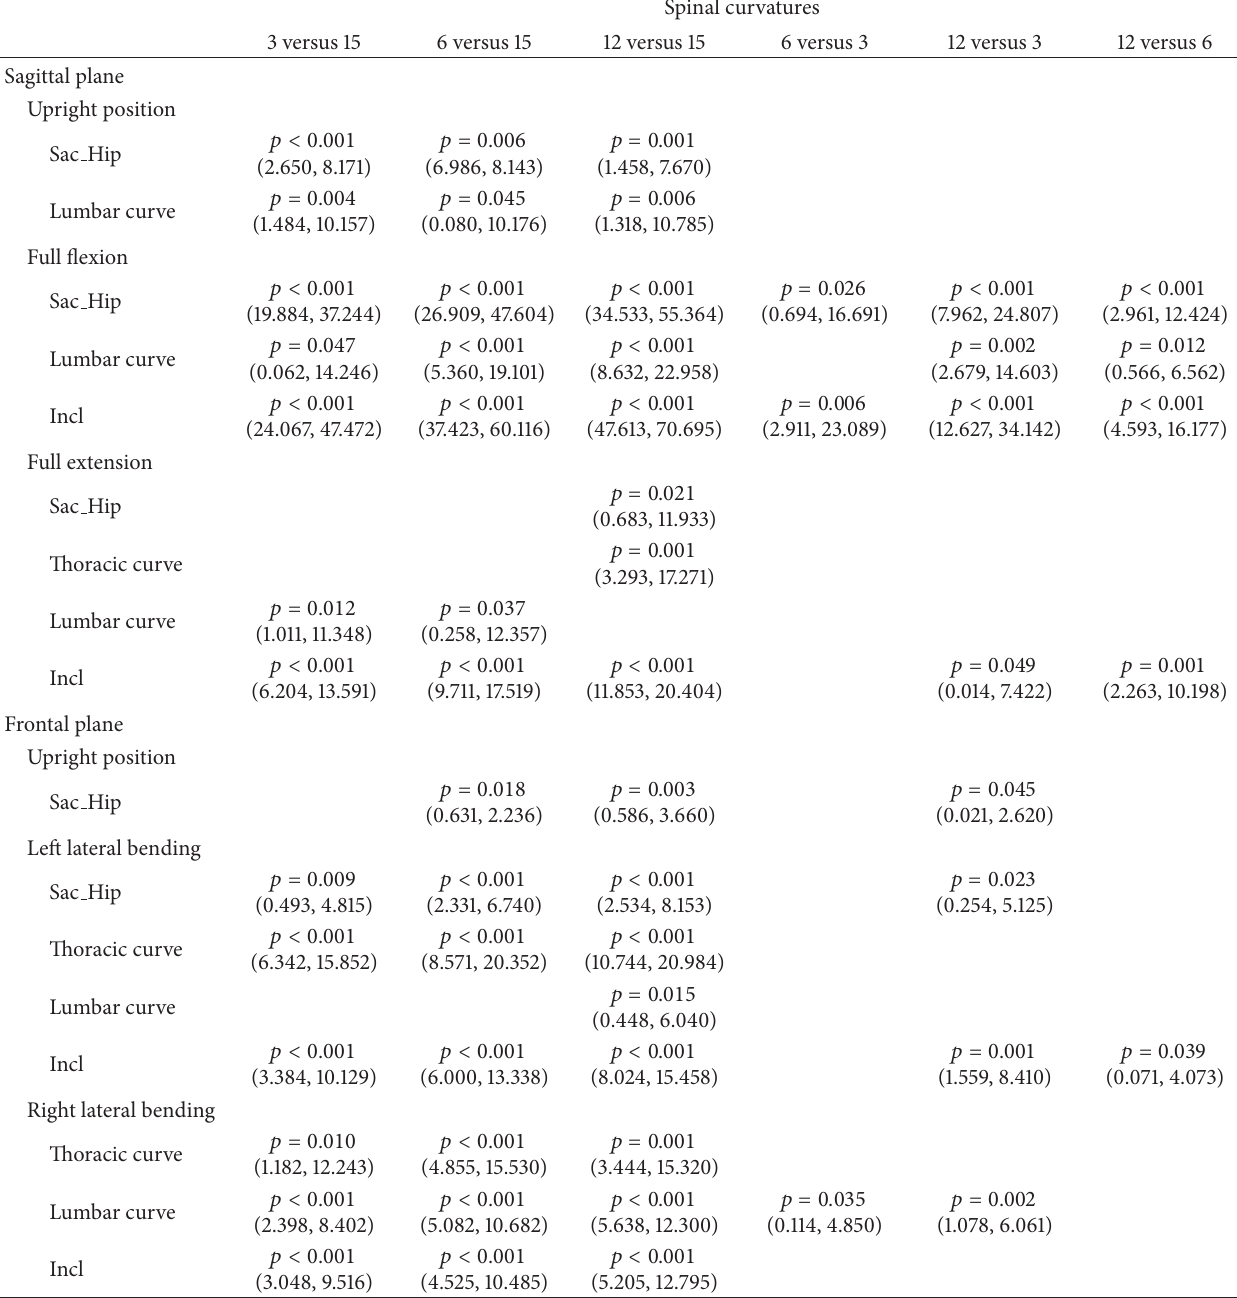
Table 2: Spine curvatures measurements for all positions in sagittal and frontal